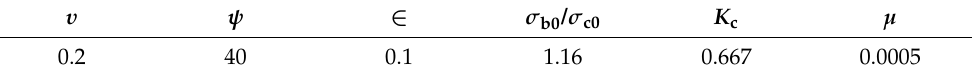
Table 1. Parameters for CDP